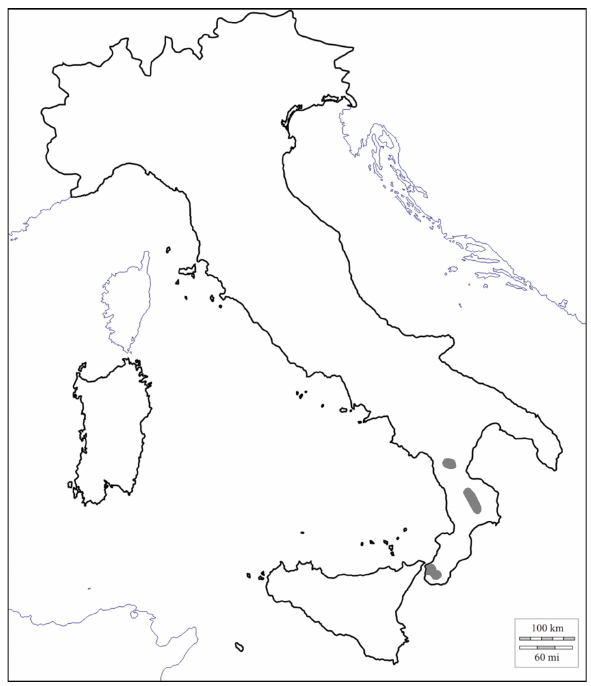
Figure 5. Distribution map of Dryomys aspromontis (redrawn from Capizzi and Filippucci 2008).